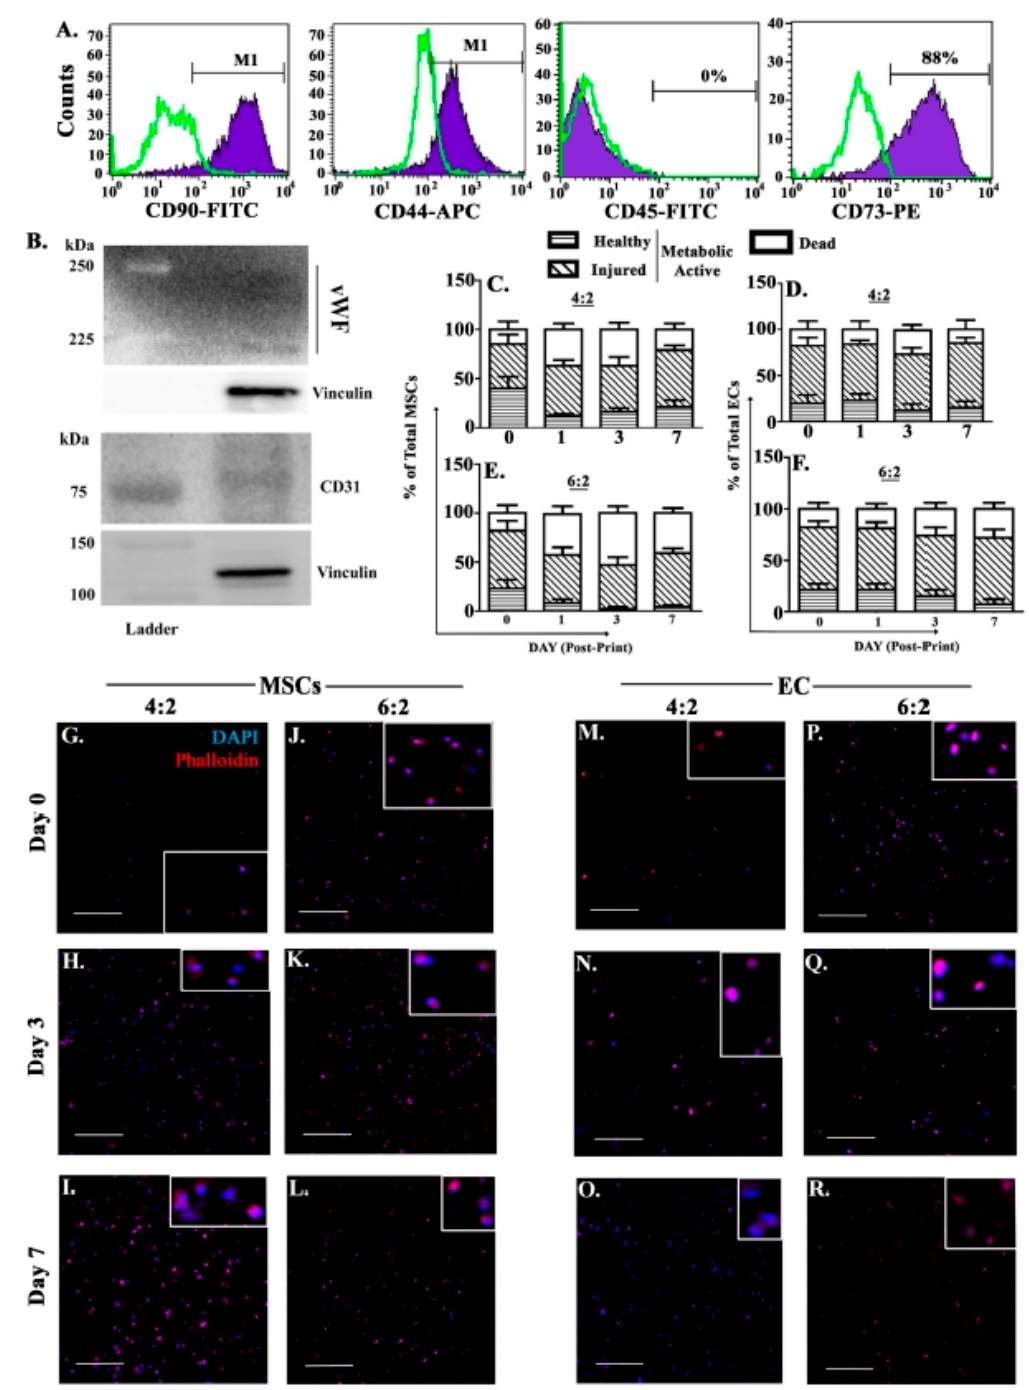
Figure 2. Cell viability and vitality are maintained by 4:2 and 6:2 bioinks. Flow cytometric analyses with MSCs labeled with anti-CD90, -44, -45 and -73 ( A ). Western blot with whole EC extracts for CD31 and vWF. Shown are the ladders that reflect the corresponding molecular weights of the test proteins ( B ). Primary human BM-derived MSCs and ECs were printed into 4:2 ( C , D ) and 6:2 ( E , F ) scaffolds, respectively. Timeline cell viability and vitality analyses were assessed up to day 7 as described in Materials and Methods. Viable cells are those deemed to be healthy and injured. The analyses represent 4 independent experiments, each with a different donor. Confocal microscopy imaged the cells at days 1, 3 and 7 within the scaffolds: MSCs in 4:2 ( G – I ) and 6:2 ( J – L ); ECs in 4:2 ( M – O ) and 6:2 ( P – R ). Shown are representative images at 10X magnification. Blue: DAPI (nuclei). Red: rhodamine phalloidin (actin). Scale bar: 250 µm.